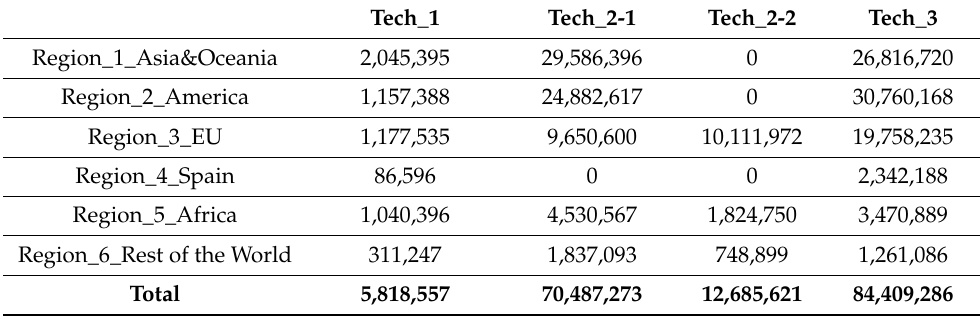
Table 13. Technology-specific factor, ↑ 10% y2. x by region and technology (million $).